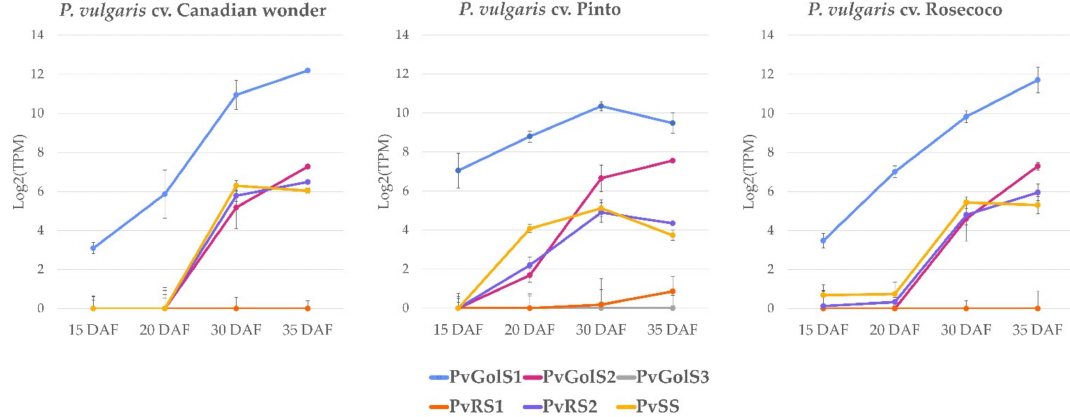
Figure 5. RNA-seq expression analysis of the galactinol- and RFO biosynthesis genes during seed development in P. vulgaris cvs. Canadian wonder, Pinto and Rosecoco. The normalized expression values of GolS1 ( PvGolS1 ), GolS2 ( PvGolS2 ), GolS3 ( PvGolS3 ), RS1 ( PvRS1), RS2 ( PvRS2 ) and SS ( PvSS ) in the seed are shown during different developmental stages: 15, 20, 30 and 35 days after flowering (DAF). The expression values are log2 transformed and expressed in transcripts per million (TPM). Error bars represent the standard